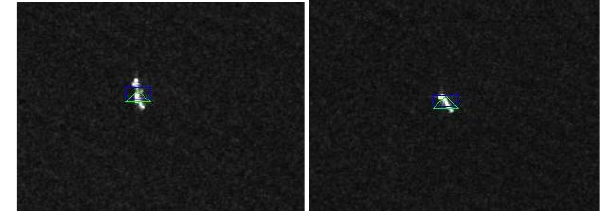
Fig.2 Zoom-ins of detected ship targets. A detected target is considered a ship taking association with detections over all the polarization channels.